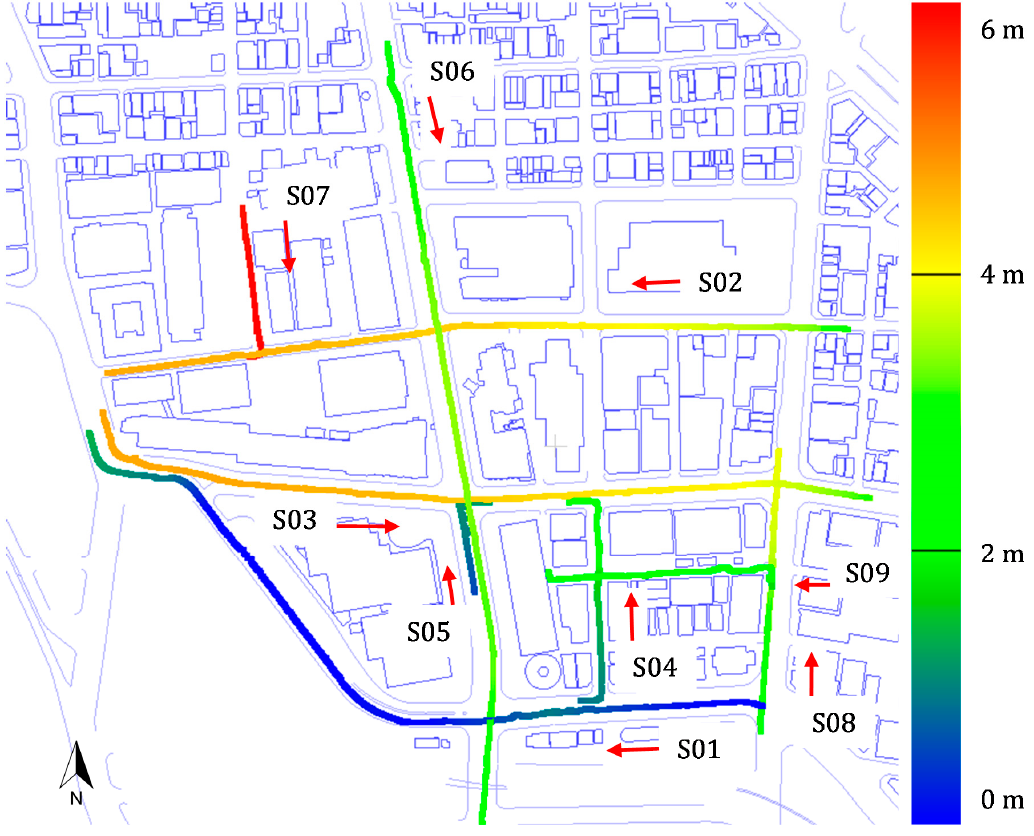
Figure 20. Routes of the nine surveys S01–S07 on the map. The colors show the estimated GPS error reported by MMS.